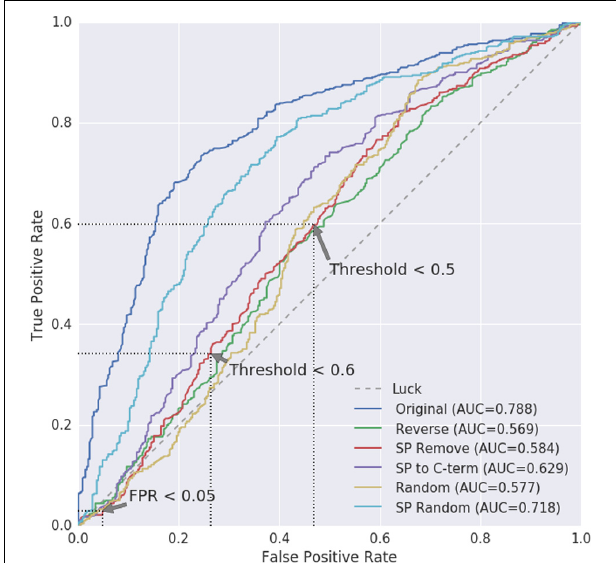
FIGURE 6 | Receiver operating characteristic (ROC) curves for positive WallProtDB Arabidopsis proteins vs. the negative class of ASURE proteins from the nucleus and/or cytosol. Area Under Curve (AUC) values are shown for each protein modification. The AUC for random (pure chance/luck) is 0.5. As the threshold for classification is reduced, the true positive (TPR) and false positive (FPR) rates are mapped to the axes, giving visual insight into how the classifier balances true and false positives and which thresholds might be considered most appropriate. The preferred path of an ROC is toward the upper left hand corner signifying a high true positive rate and low false positive rate. Three points on the SP Remove curve are annotated corresponding to when either the FPR is < 0.05 or threshold is set to 0.5 or 0.6. The exact values are listed in Supplementary Table